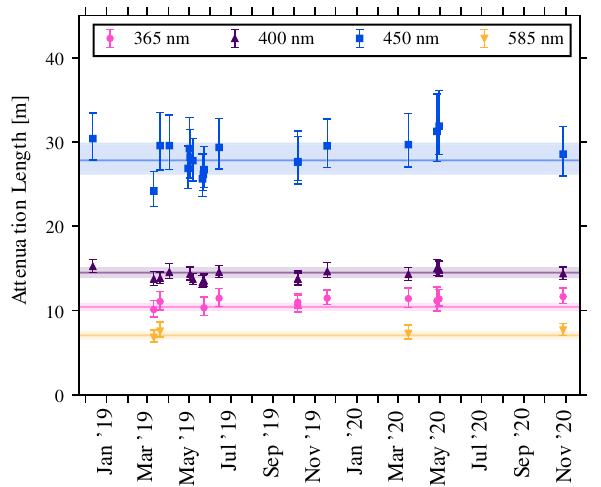
Fig. 7 Long term study of the attenuation length over 2 years. The error bars on the individual data points contain the uncertainties of the nuisance parameters and are therefore highly correlated. The solid lines with error bands represent the results from the all-data joint fit (Fig. 5). The data points from Fig. 6 are not shown in this plot